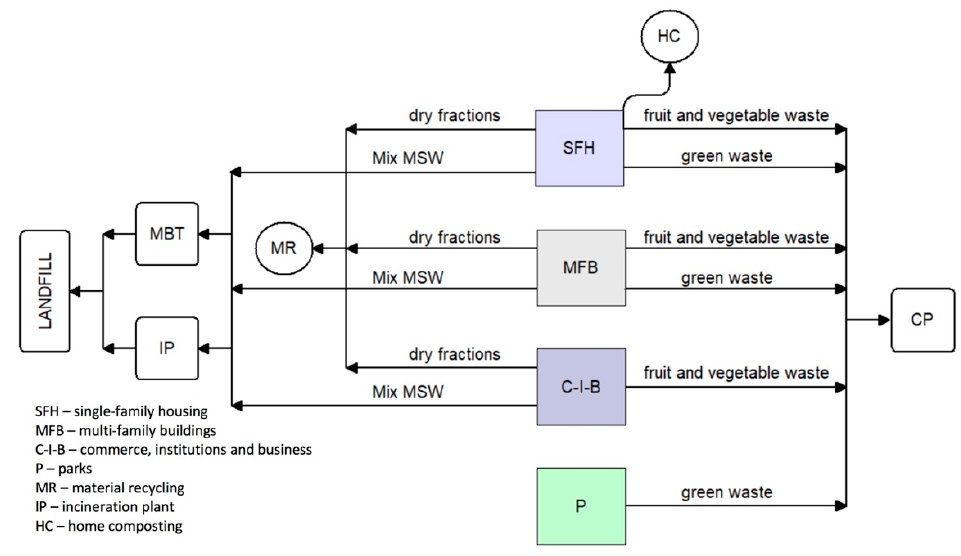
Figure 1. Flow diagram in TS ‐ I.